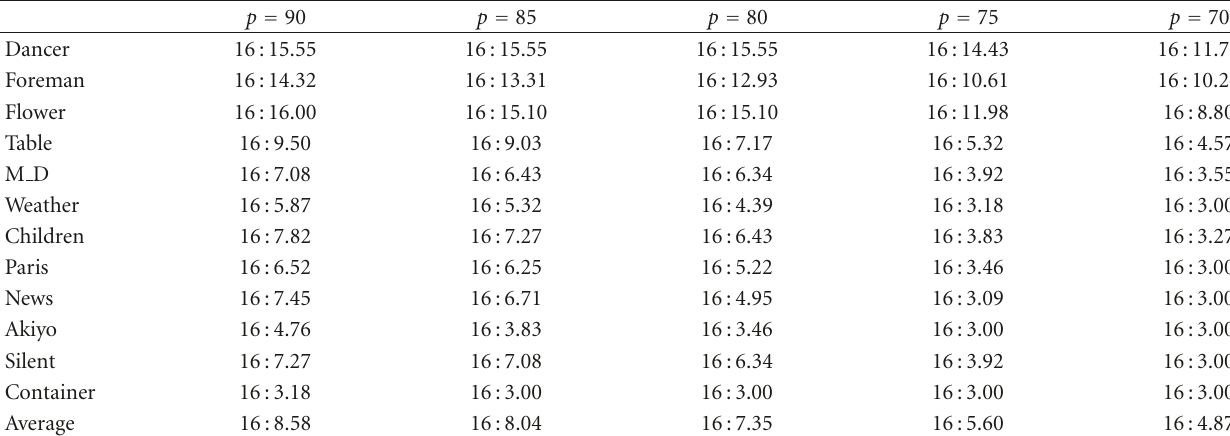
Table 4: Analysis of average subsample ratio using three adaptive subsample rate decisions.